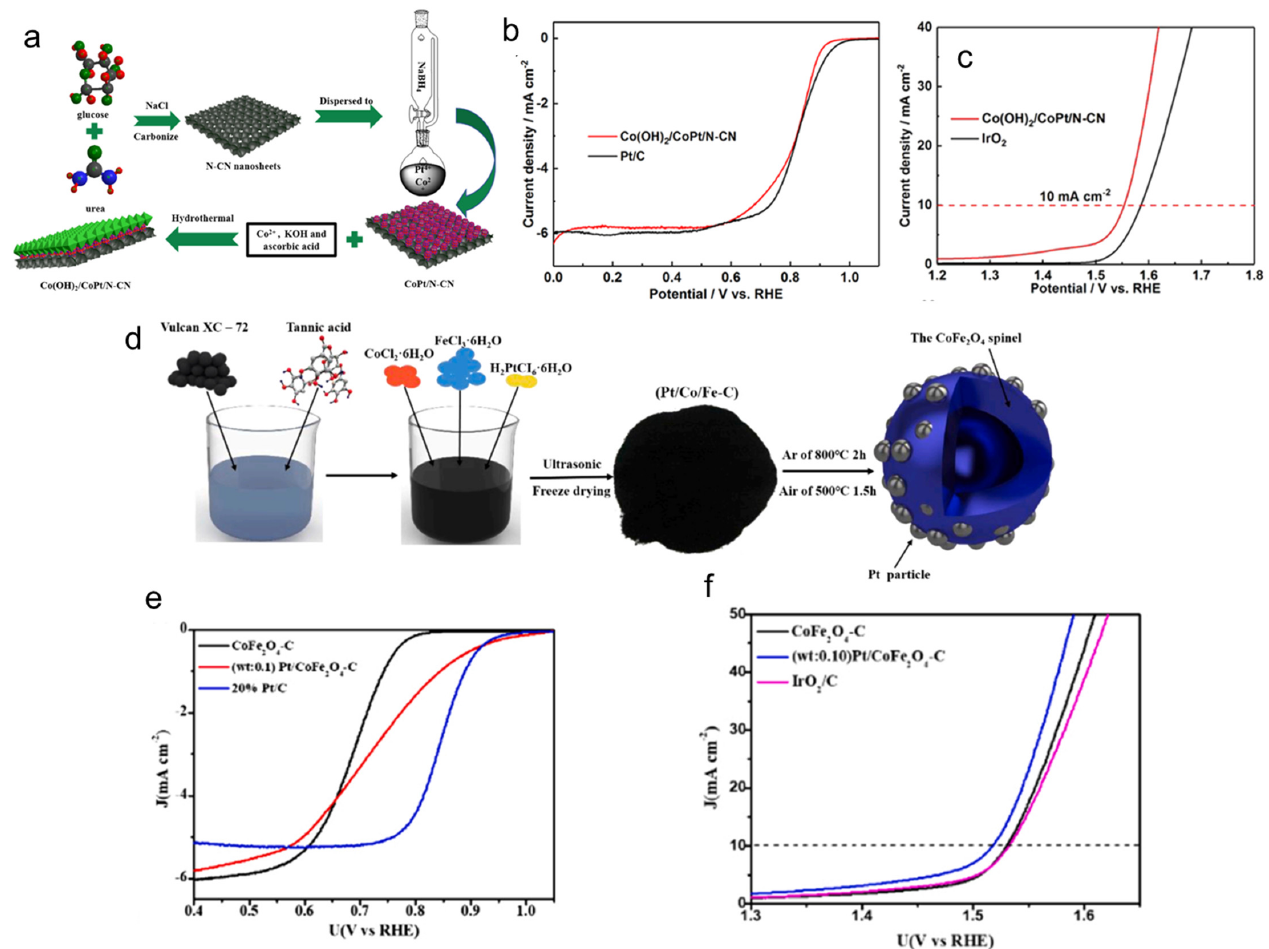
Figure 1. Typical preparation procedure and oxygen-related reaction performance of Co(OH) 2 /CoPt/N − CN and SA − PtCoF. ( a ) Schematic of preparation of Co(OH) 2 /CoPt/N − CN composite. ( b , c ) ORR and OER performance, respectively, of Co(OH) 2 /CoPt/N − CN. Reproduced from [17], copyright 2019, Chemical Society of America. ( d ) Schematic illustration of fabrication process for Pt/CoFe 2 O 4 − C. ( e , f ) ORR and OER performance, respectively, of Pt/CoFe 2 O 4 − C. Reproduced from [19], copyright 2021, Elsevier.